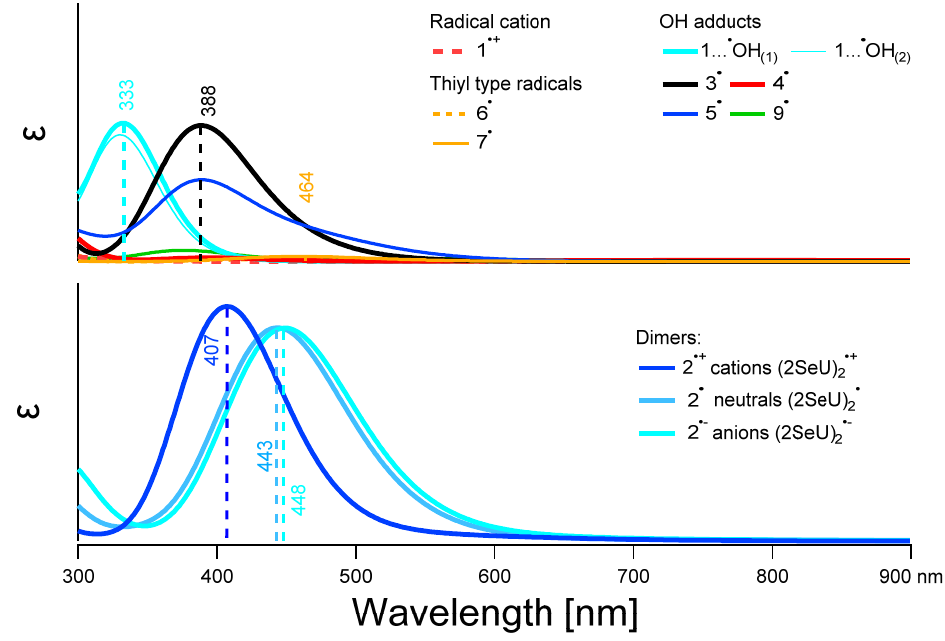
Figure 12. TD-DFT calculated absorption spectra of potential transients (see legend for symbols) produced in ● OH–induced oxidation of 2SeU in water at pH lower than its first p K a (7.18). Monomer-type transients derived from singly deprotonated 2-SeU along with